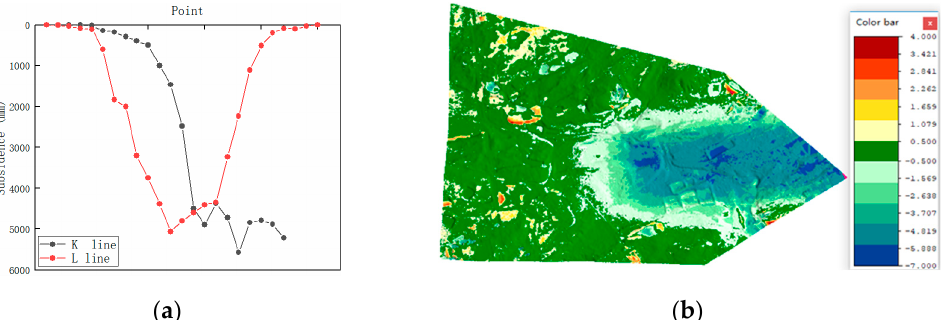
Figure 12. Schematic diagram of surface subsidence at the mine area: ( a ) K line and L line; ( b ) Surface area subsidence.